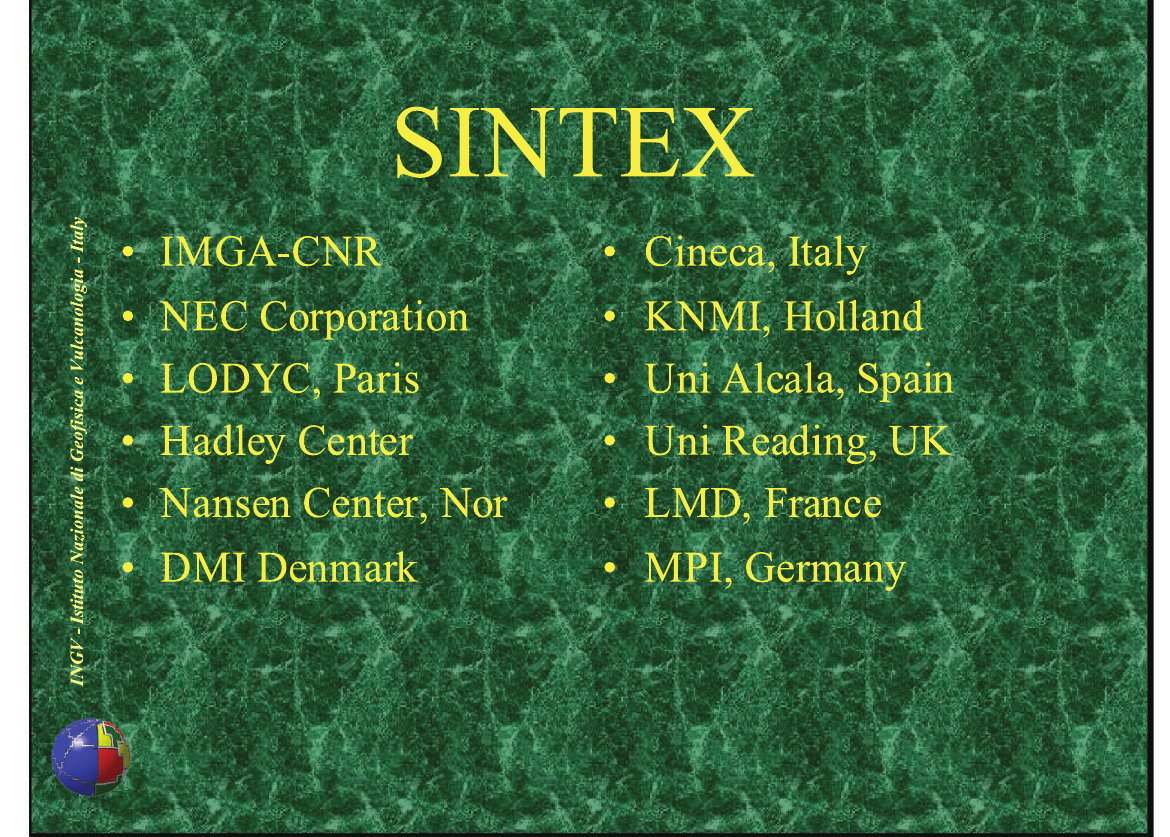
Fig. 2. The partners of SINTEX in the original slide. IMGA-CNR, Italy; NEC Supercomputing, Germany; LODYC, France; Hadley Center, U.K.; Nansen Center, Norway; Danish Meteorological Institute, Denmark; CINECA, Italy; KNMI, Holland; Universidad de Alcalá, Spain; University of Reading, U.K.; Laboratoire de Météorologie Dynamique, France; Max-Planck Institute für Meteorologie,